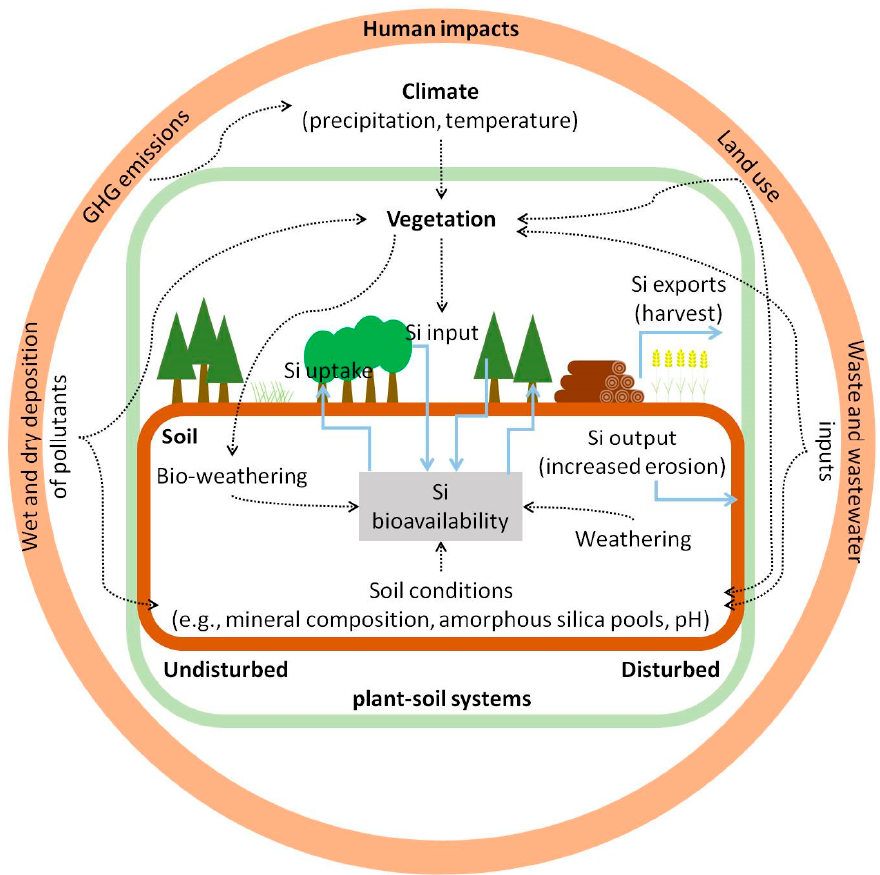
Figure 4. Schematic overview of Si cycling in undisturbed (unused, natural) and disturbed (used) plant–soil systems. Si bioavailability in soils, and thus Si cycling, is strongly influenced by human impacts, i.e., greenhouse gas (GHG) emissions, land use (agriculture, forestry), pollution via wet and dry deposition, and waste and wastewater inputs.